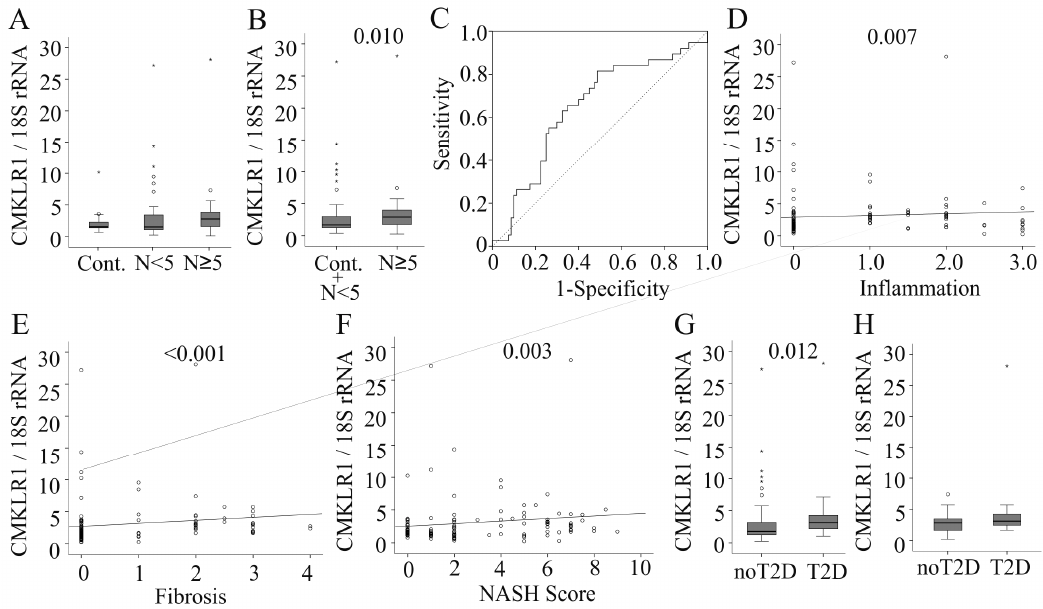
Figure 2. CMKLR1 mRNA (normalized for 18S rRNA) in non-alcoholic fatty liver disease (NAFLD). ( A ) CMKLR1 mRNA in liver tissues of patients with healthy liver (Cont.), a non-alcoholic